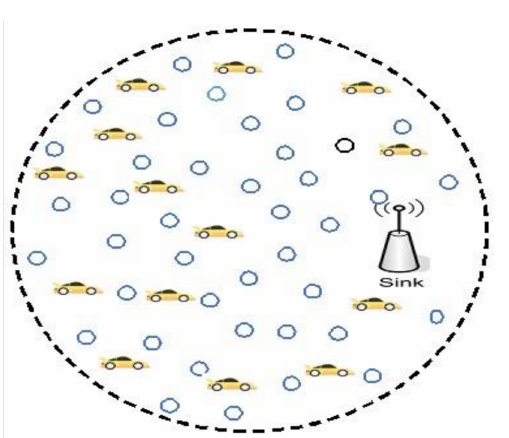
Figure 2. The network